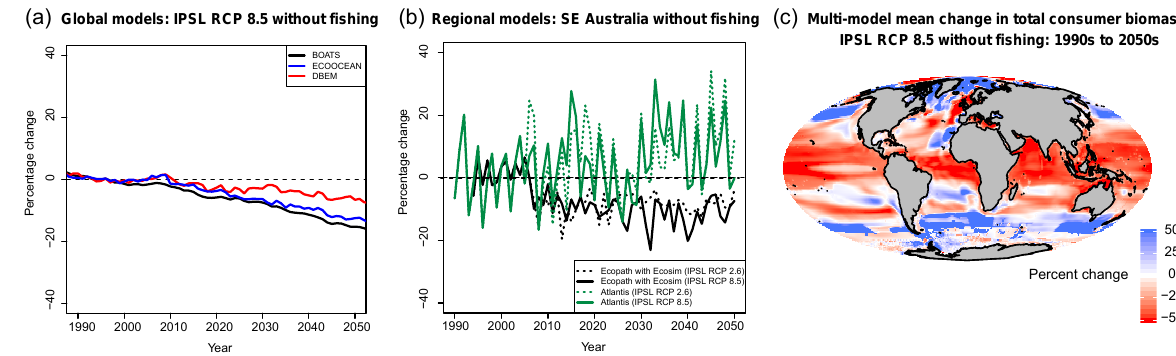
Figure 1. Example outputs from the Fish-MIP v1.0 protocol core simulations. (a) Global model time series output. Percentage change in global spatially averaged total consumer carbon biomass density (gm − 2 ) from 1990 to 2050. All values are relative to the 1990–1999 mean. Values are shown for three marine ecosystem models: a size-based model (BOATS), a trophodynamic model (EcoOcean), and a species distribution model (DBEM). Output only shown for IPSL RCP 8.5 model runs without fishing imposed. For definition of total consumer carbon biomass, see Table 5. (b) Regional model time series output. Percentage change in spatially averaged total consumer carbon biomass density (gm − 2 ) from 1990 to 2050. All values are relative to the 1990–1999 mean. Values are shown for two regional marine ecosystem models in southeast Australia: a trophodynamic model (Ecopath with Ecosim) and a composite (hybrid) model (Atlantis). The spatial extent of models is overlapping but non-identical. Output only shown for IPSL RCP 2.6 and IPSL RCP 8.5 model runs without fishing imposed. (c) Global spatial model output runs (models as per panel a ) for IPSL RCP 8.5 with no fishing imposed. Ensemble model mean percentage change in total consumer carbon biomass density (originally in gm − 2 ) from the 1990s to the 2050s; a positive value indicates an increase over time. Percentage changes in each grid cell for the three models in panel (a) over this time period were averaged.